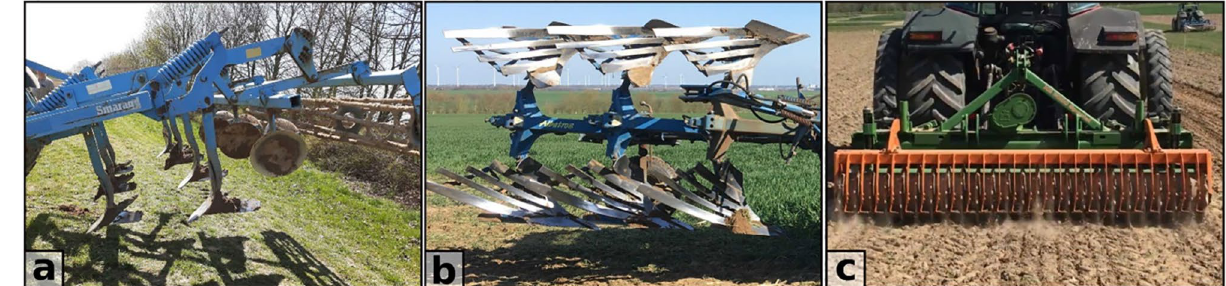
Figure 2. Implements used within tillage experiments: ( a ) chisel plough, ( b ) mouldboard plough, and ( c ) roller.